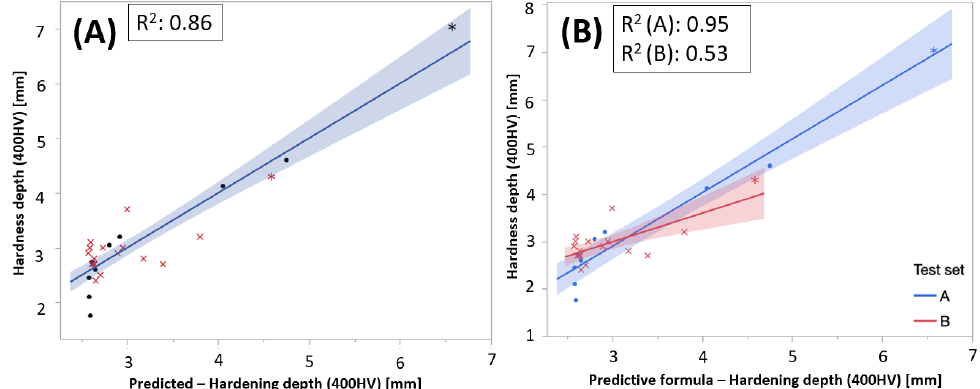
Figure 14. ( A ) Actual vs. predicted plot for the model (i), based on principal components only and ( B ) stratified on test sets.